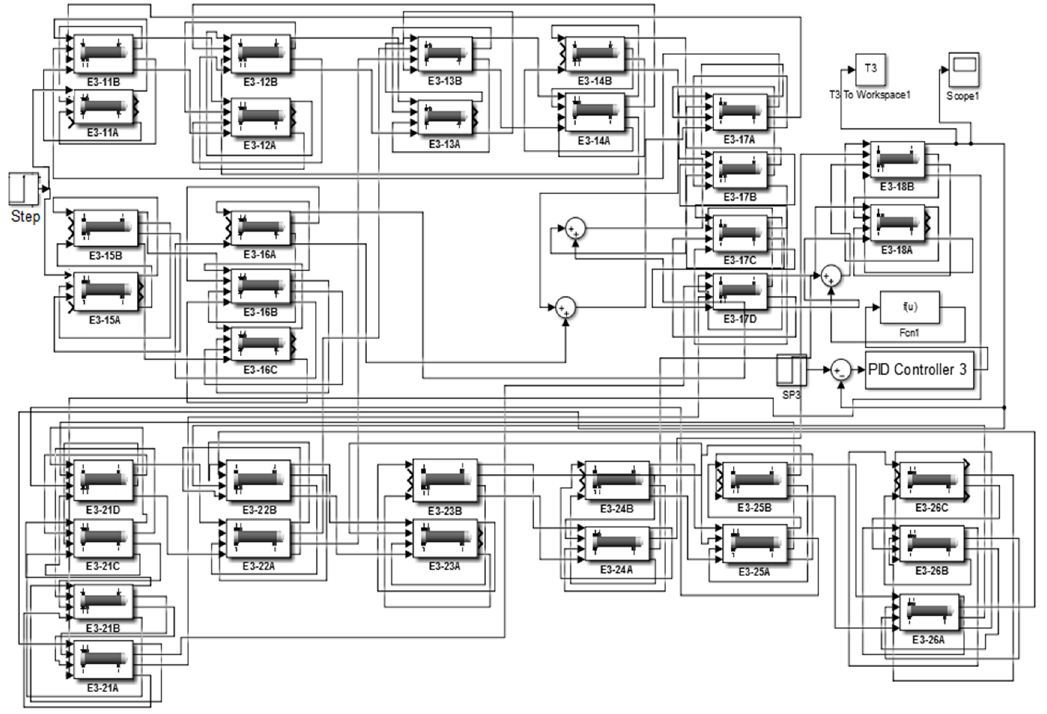
Figure 9. Scheme of the HEN with PID-control loop 3 implemented in Simulink/MATLAB. Table 2. Values of the R f and heat transfer coefficient for the studied HEN in case no. 2. Total Heat Fouling Factor HE R f × 10 − 3 (m 2 K/W) no. HE Fouling Factor after Period of Operation: no. for Clean